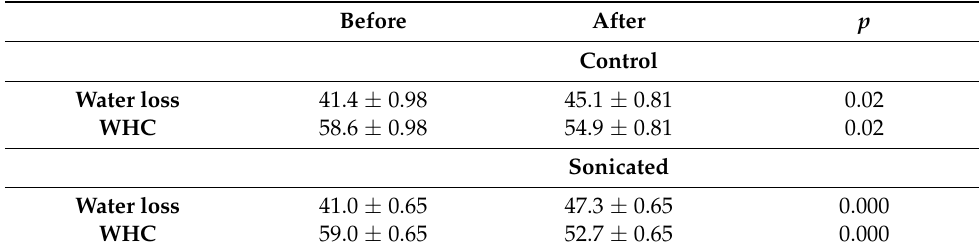
Table 1. Water dynamic of 23-day-aged beef before and after being immersed in deionized water or ultrasonicated (US, 28 W/cm 2 ) in deionized water and placed under simulated retail